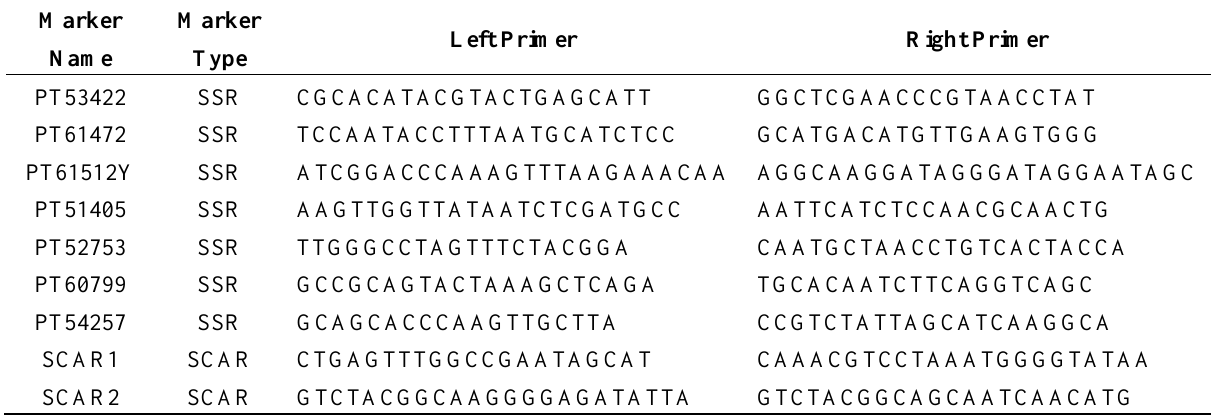
Table 1. Molecular markers described in this